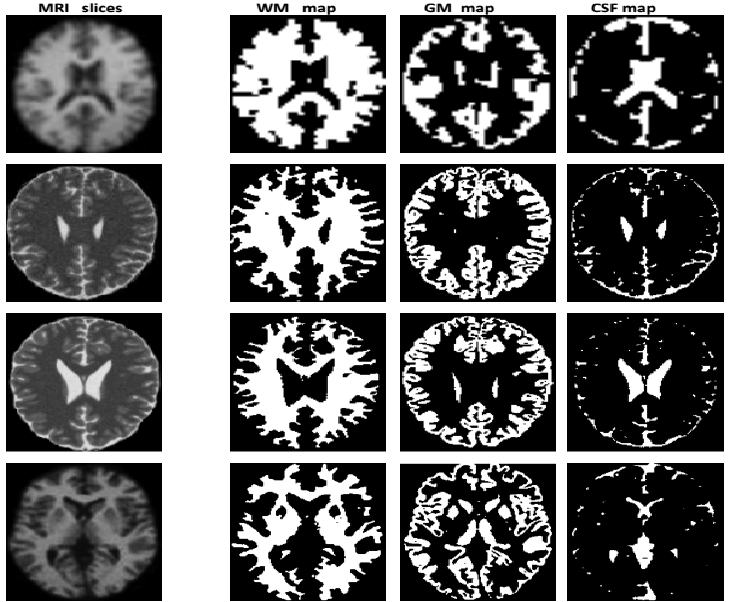
Figure 3. Fuzzy maps of WM, GM and CSF tissues calculated with PFCM modeling based on hybrid BCFCM / GA centers initialization, with additive noise level is 20%, slice thickness is 5 and inhomogeneity of the radio frequency is 20%.